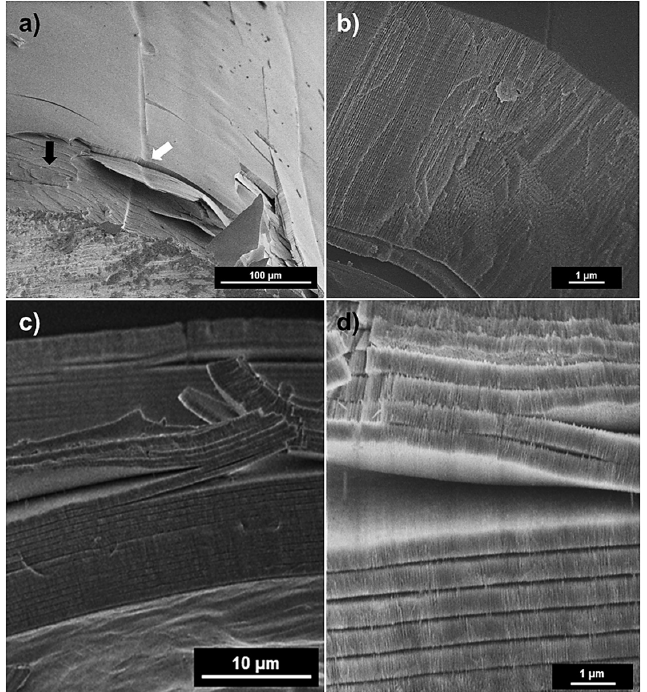
Figure 5. Examples of damages on the 3D ‐ CPAA. ( a ) Low magnification image were shallow longitudinal defects and terraces appear. The black arrow points out terraces and the white arrow points out shallow longitudinal effect. ( b ) A cross ‐ sectional view of the shallow defect pointed at (a). Over ‐ etching effect on S540 type sample is visible in ( c ), where the structure starts to exfoliate in layers defined by the transversal nanochannels. A close ‐ up of (c) is presented on ( d ).